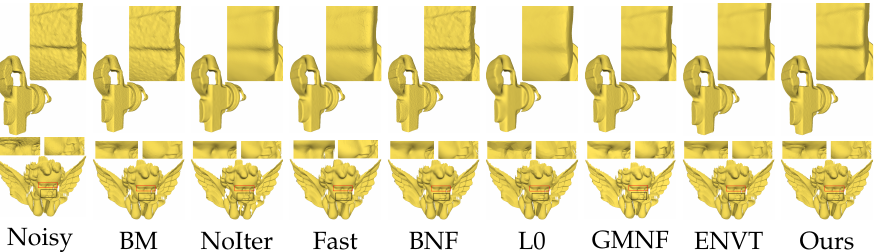
Figure 15. Comparison of the denoising results for the scan model. The results From left to right: [3–5,23,27,28,45] and